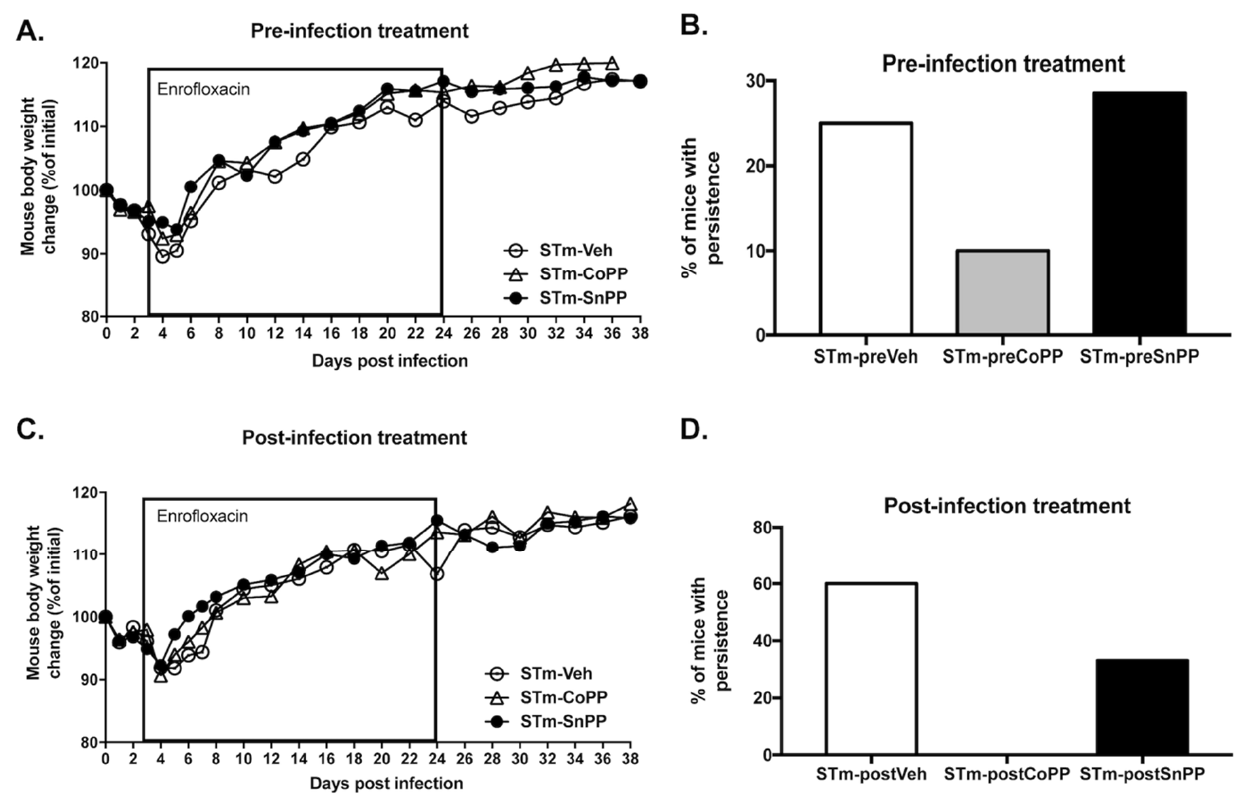
Figure 3. Hmox1 induction by CoPP treatment reduces persistent S. Typhimurium infection model in mice. Female C57BL/6 mice were treated with CoPP, SnPP, or vehicle 24 h before ( A , C ) or 72 h after ( B , D ) intragastric infection with 1 × 10 6 CFU of S. Typhimurium. In both cases, Enrofloxacin was administered in the drinking water from day 3 to day 24, to allow mice to survive to infection and promote bacterial persistence until the end of the experiment. On day 38 post-infection, mice were euthanized and bacterial loads were measured in organs and blood. ( A , C ) Weight change is represented as a percentage of initial weight. ( B , D ) Percentage of mice with persistent infection at 38 days post-infection in at least one organ/blood (STm-preVeh n = 8; STm-preCoPP n = 10; STm-preSnPP n = 14; STm-postVeh = 5; STm-postCoPP = 6; STm-postSnPP n = 12; 3 independent experiments). No significant differences were observed in the weight change of mice. Prospective analysis was performed: for B: chi-square = 10.30 and p = 0.0055; for D: chi-square = 84.34 and p < 0.0001.